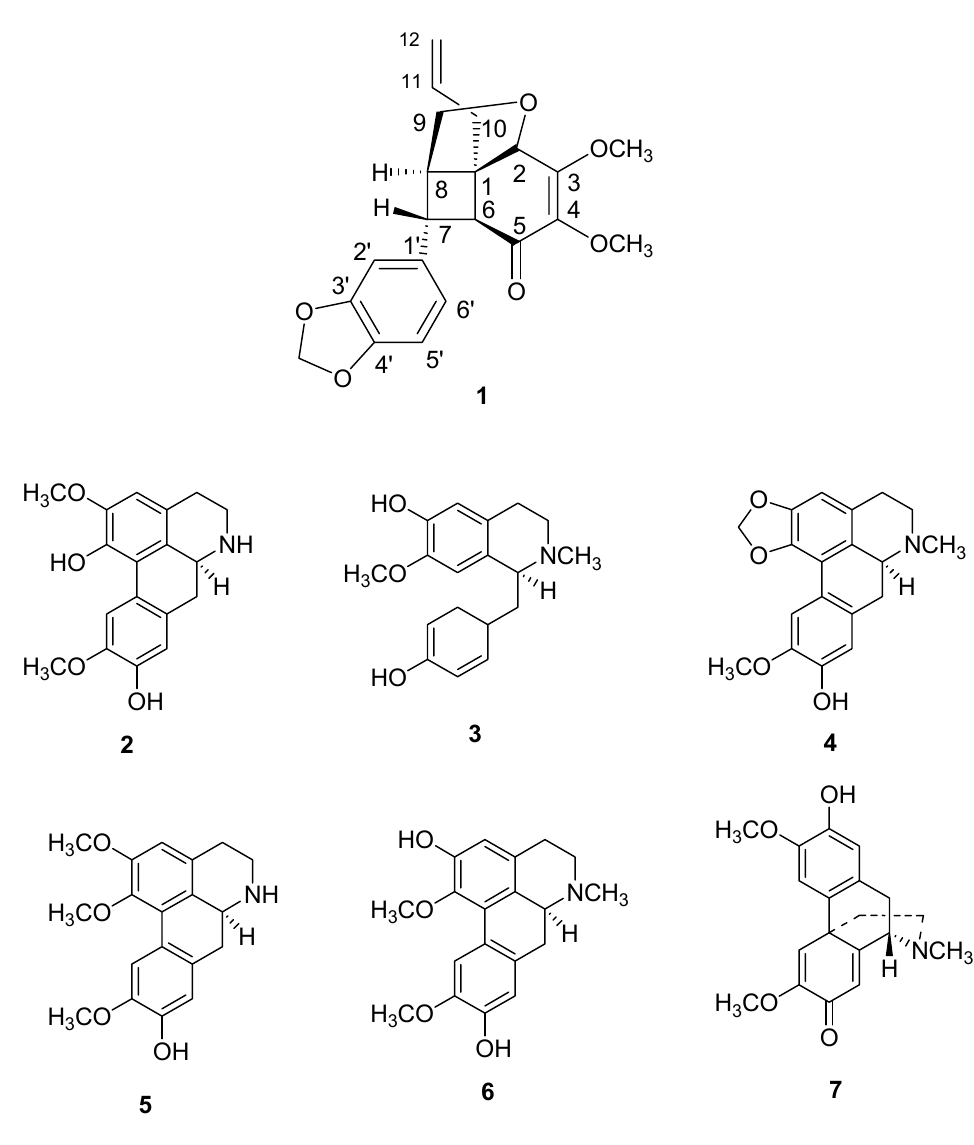
Figure 1. Chemical structures of compounds 1-7